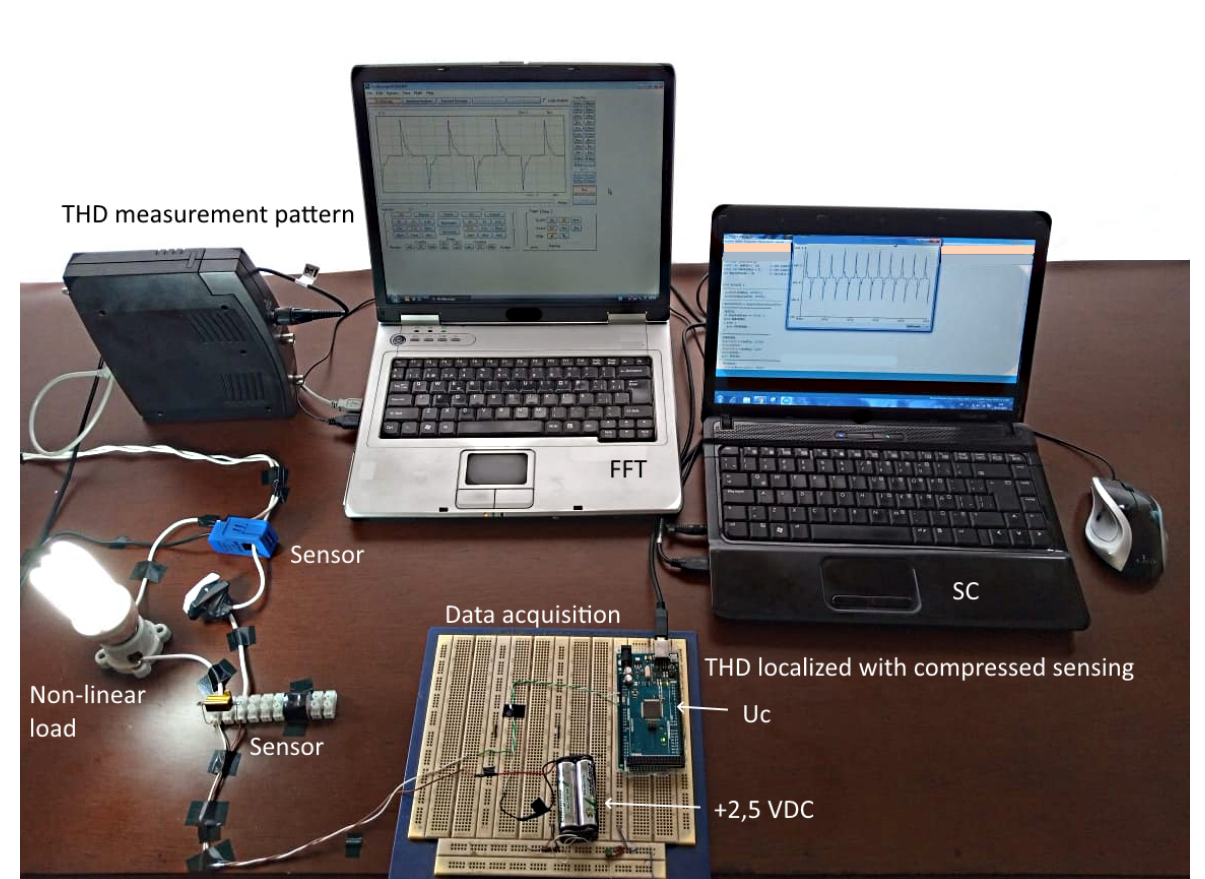
Figure 16. Hardware implemented in the experimental